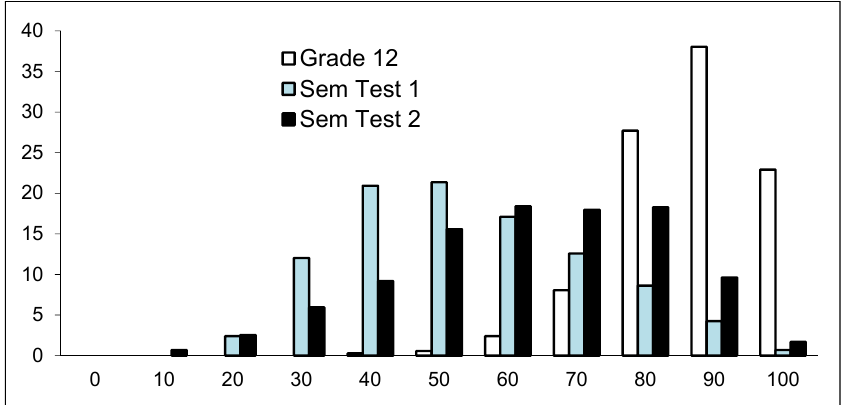
Figure 2 : Student performance in Grade 12 and in Semester Tests 1 and 2